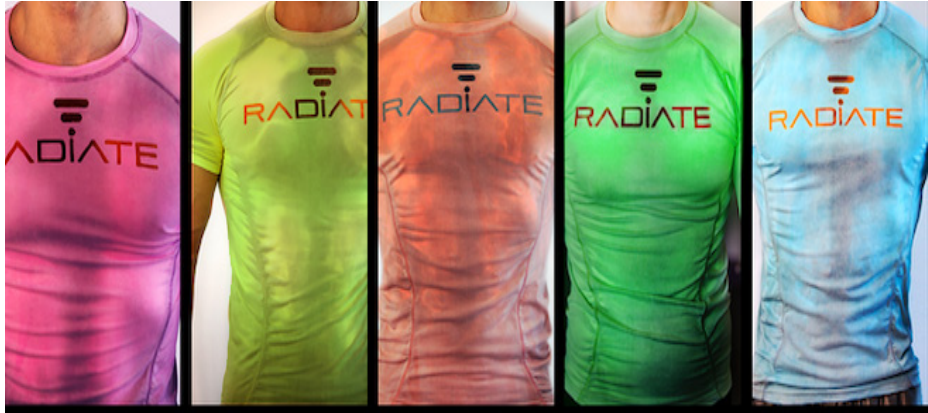
Figure 2. The Radiate sports T-shirt with various colors [67].